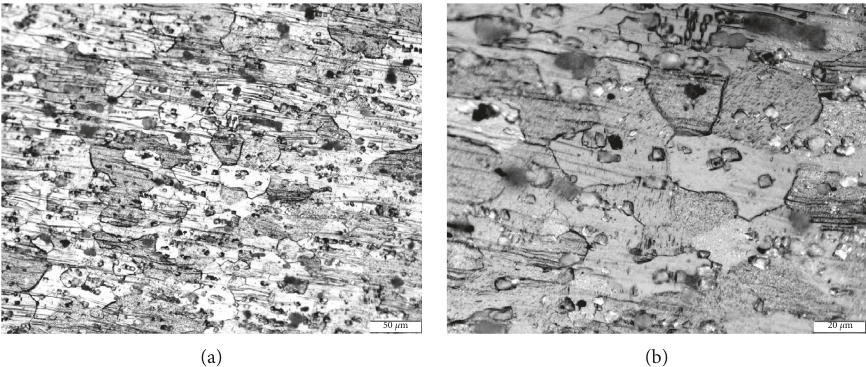
Figure 3: Optical micrographs of BM of AA5754 at different magnifications for the same location.